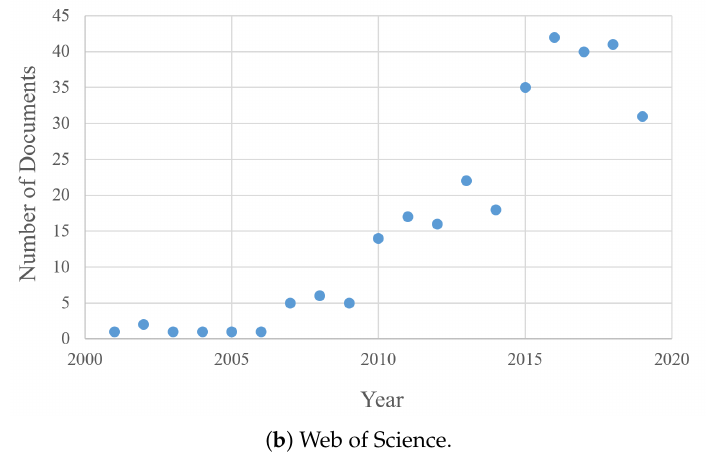
Figure 1. Results distribution along the years (adapted from Scopus and Web of Science